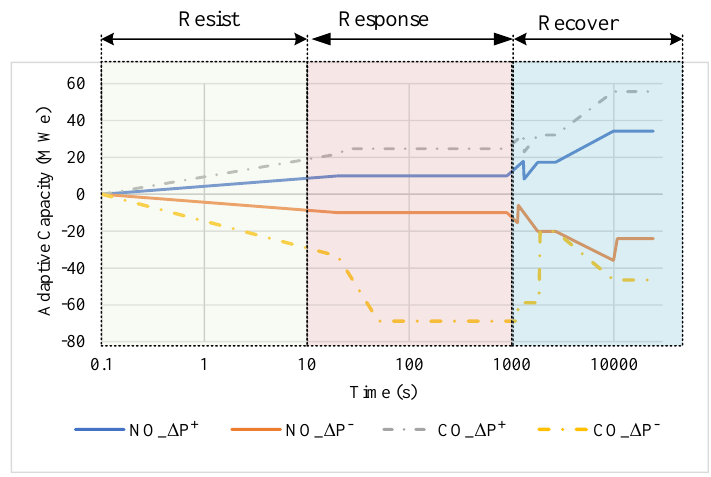
Figure 14. Adaptive capacity curve mapped to represent DIRE